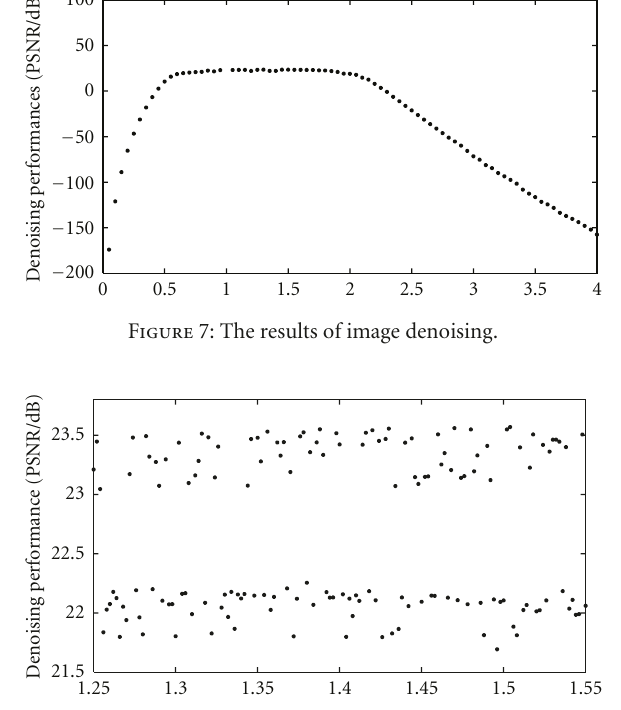
Figure 8: Denoising result within a narrow range.